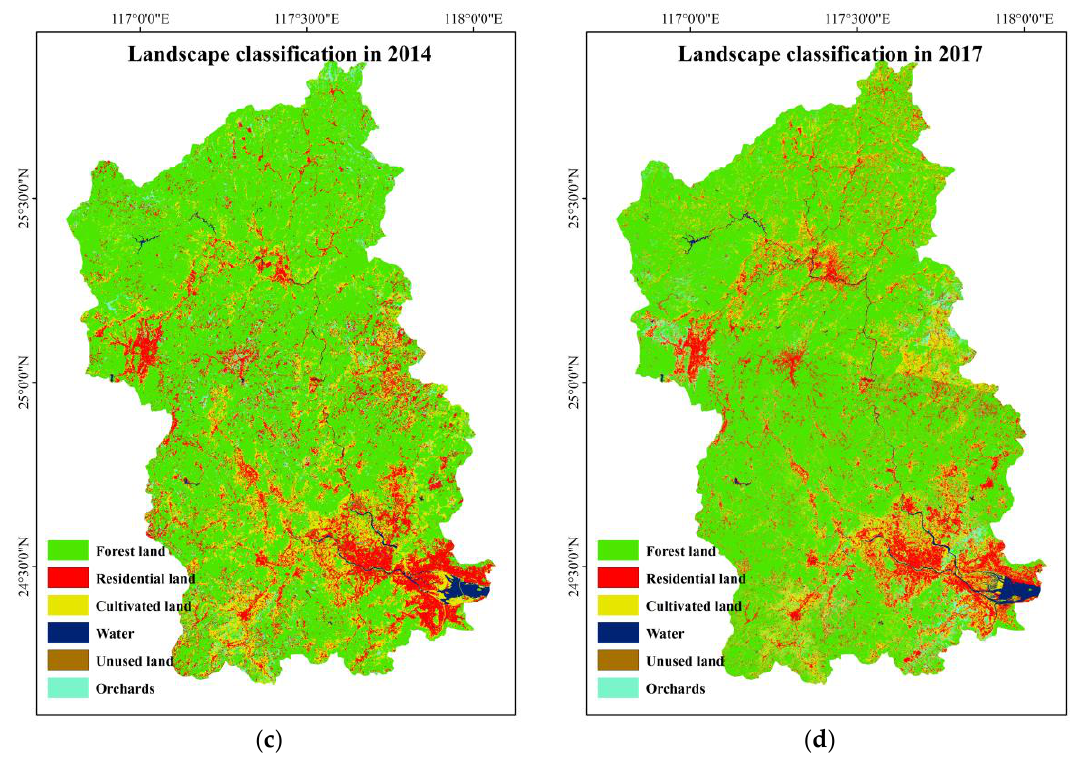
Figure 2. Classification results of multitemporal remote sensing images in Jiulong River basin. ( a ) Landscape classification in 2005; ( b ) Landscape classification in 2010; ( c ) Landscape classification in 2014; ( d ) Landscape classification in 2017.